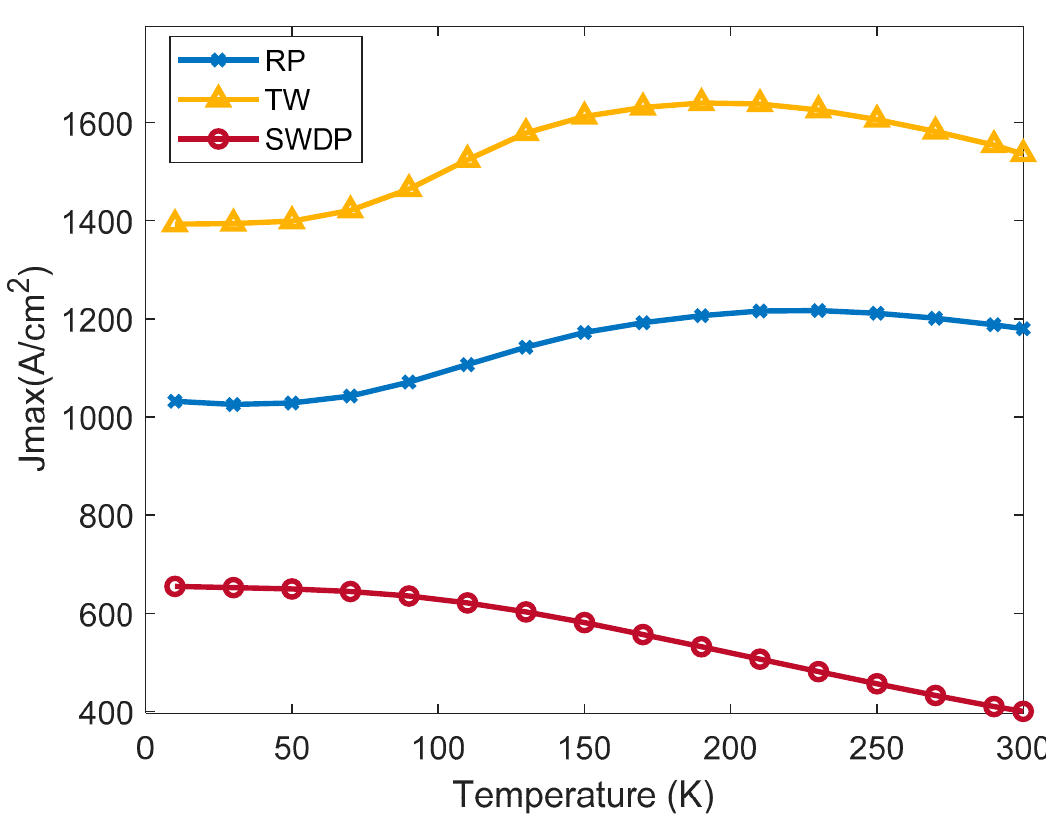
Figure 5. Maximum current density as a function of temperature for the RP, TW, and SWDP designs.